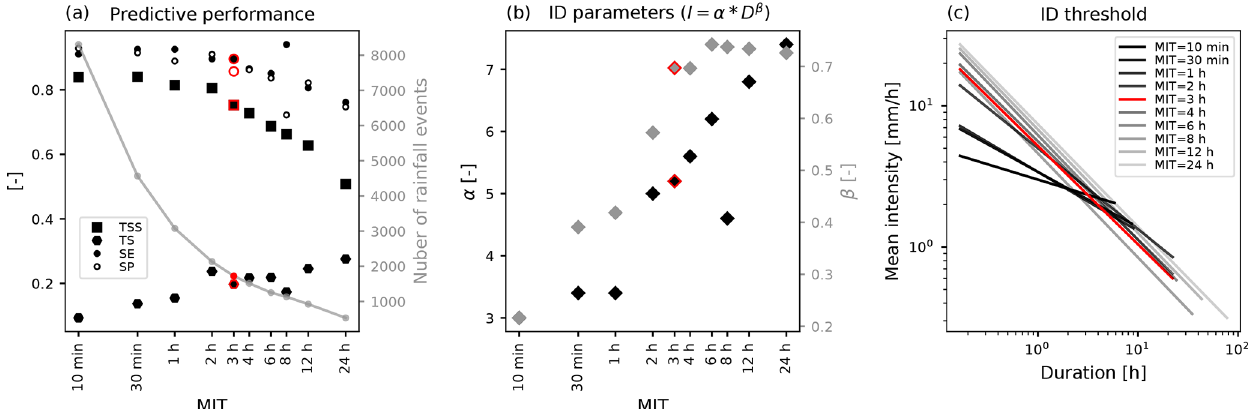
Figure 2. ID thresholds and their predictive performance statistics as a function of the rainfall event definition (minimum inter-event time, MIT). (a) Analysis of the true skill statistic (TSS), threat score (TS), sensitivity (SE) and specificity (SP) as a function of MIT. The number of rainfall events also varies with MIT and is shown in grey. (b) Analysis of ID-threshold parameters as a function of MIT. (c) Visualization of ID thresholds for different values of MIT. An MIT of 3h (red) was chosen for this study (see